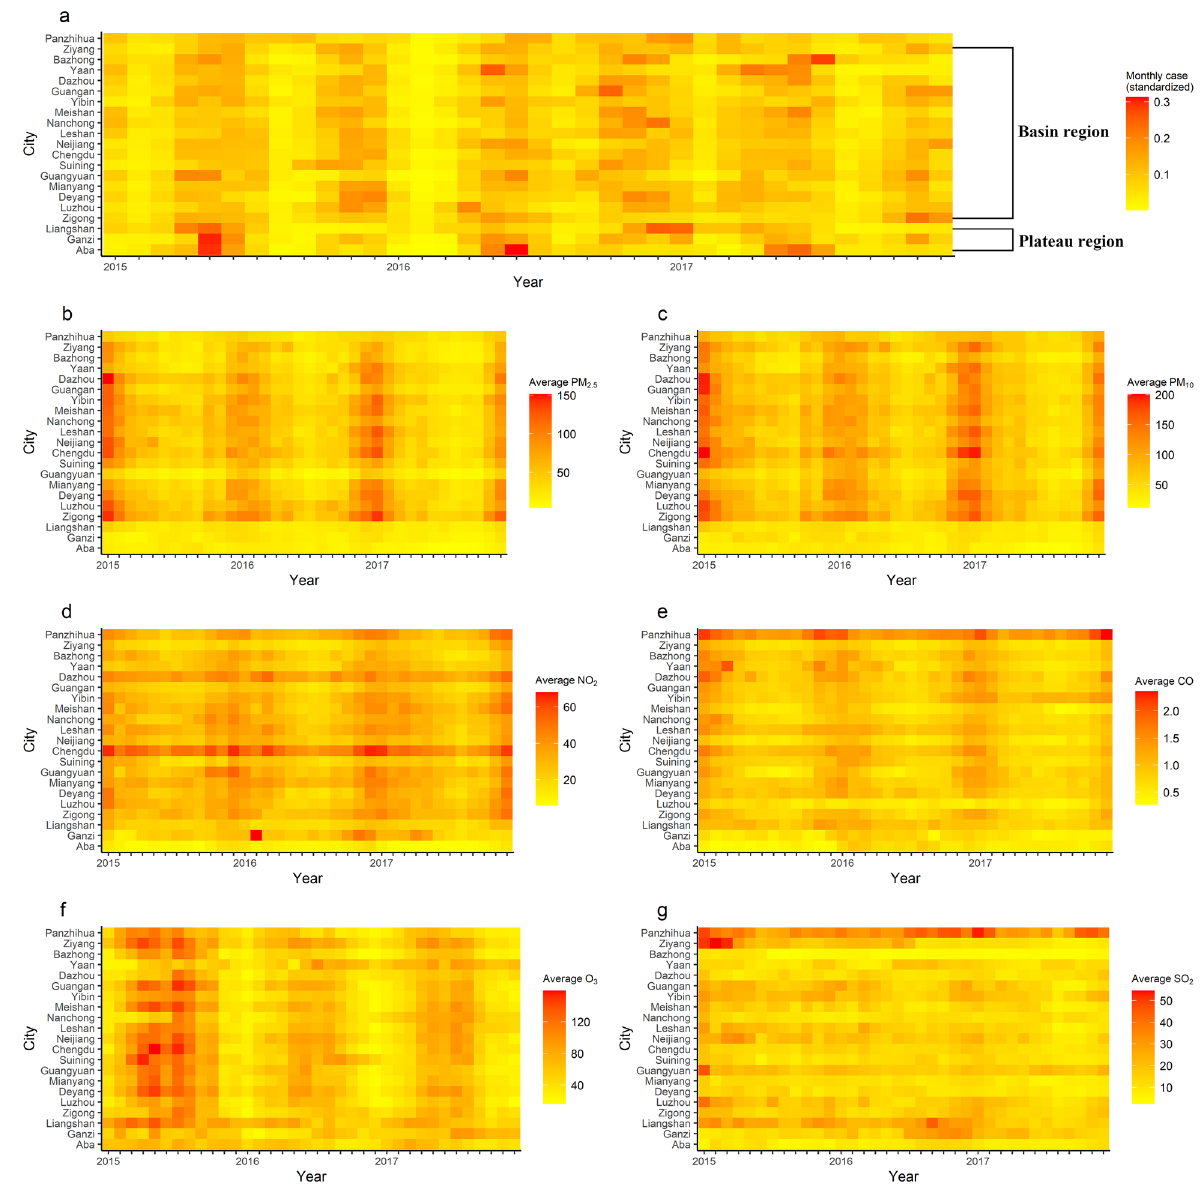
Figure 1. Heatmaps of ( a ) monthly HFMD cases (standardized by the number of annual cases), ( b ) average